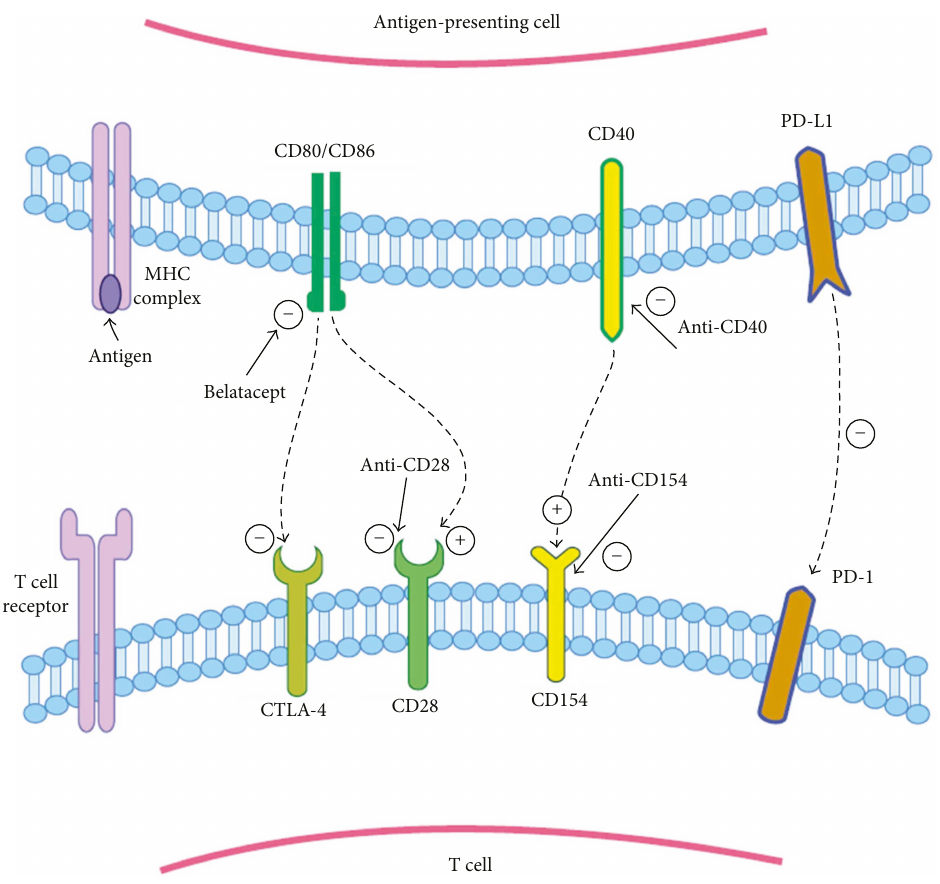
Figure 1: Costimulation pathways in T cell regulation. Upon MHC-antigen interaction with the TCR, costimulation pathways can augment or suppress the activation of the T cell. From left to right, CD28 is activated by CD80/CD86. CTLA-4 coinhibitor competes with CD28 for binding to CD80/CD86. CTLA-4Ig and belatacept work by taking advantage of their higher a ffi nity to CD28 over CD80/CD86 and thereby block CD80/CD86 activation of CD28. CD154 and CD40 are other potent activators of T cells; monoclonal antibodies against either of these surface proteins have potential for application in transplant immunosuppression. PD-1 is expressed on T cells, and interaction with PD-1 ligand (PD-L1) produces a suppressive signal to the T